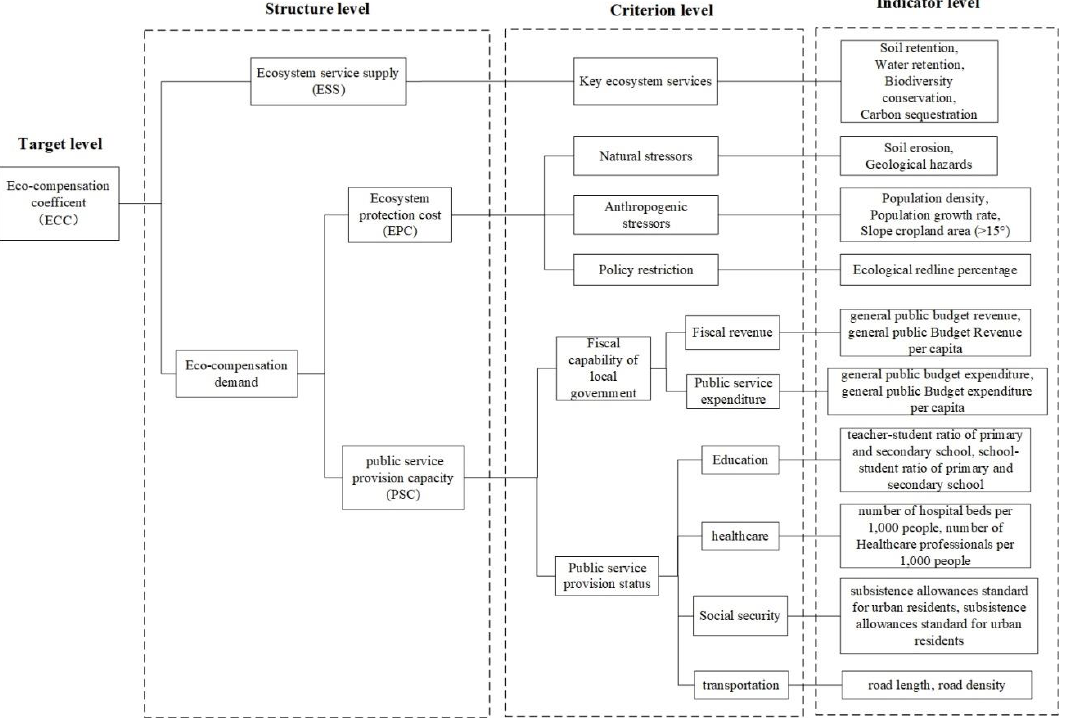
Figure 3. The supply – demand framework for eco-compensation coefficient estimation in National Key Ecological Function Counties.